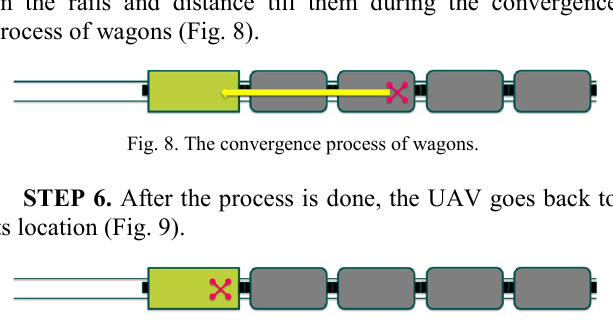
Fig. 9. UAV location at the end of the experiment.